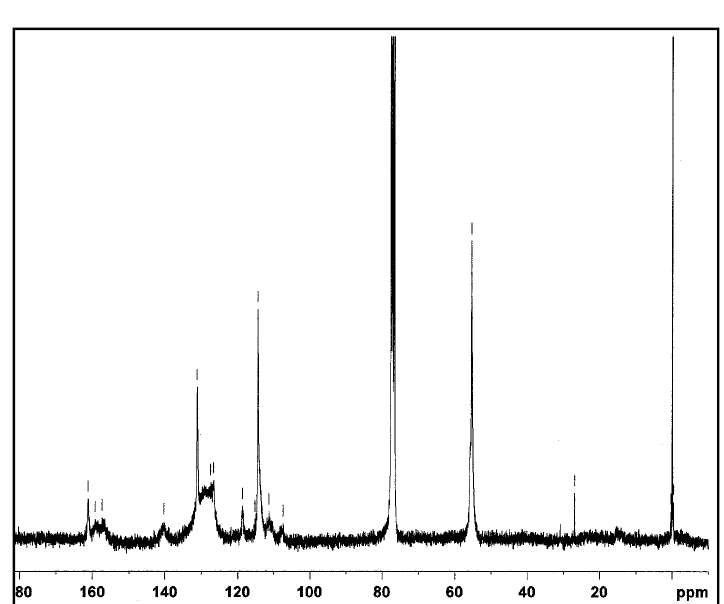
Figure 2. 13 C NMR spectra of OBMPA